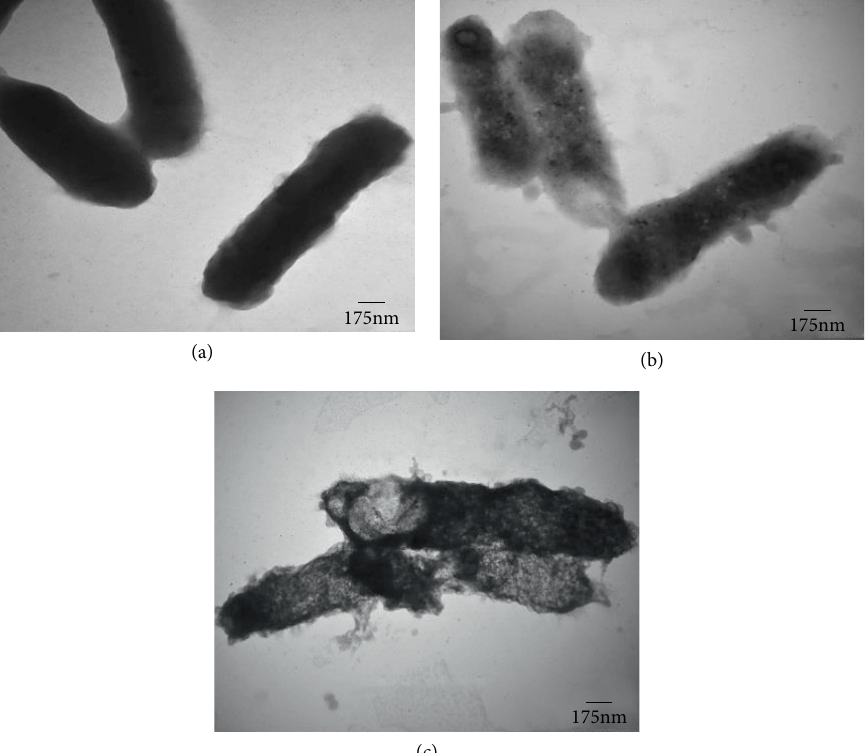
Figure 13: Effect on cellular morphology of PDR E. coli after treatment with CS-NPs coated TiO microscopy. (a) control, (b) 3 hrs of incubation, (c) 6 hrs of incubation.